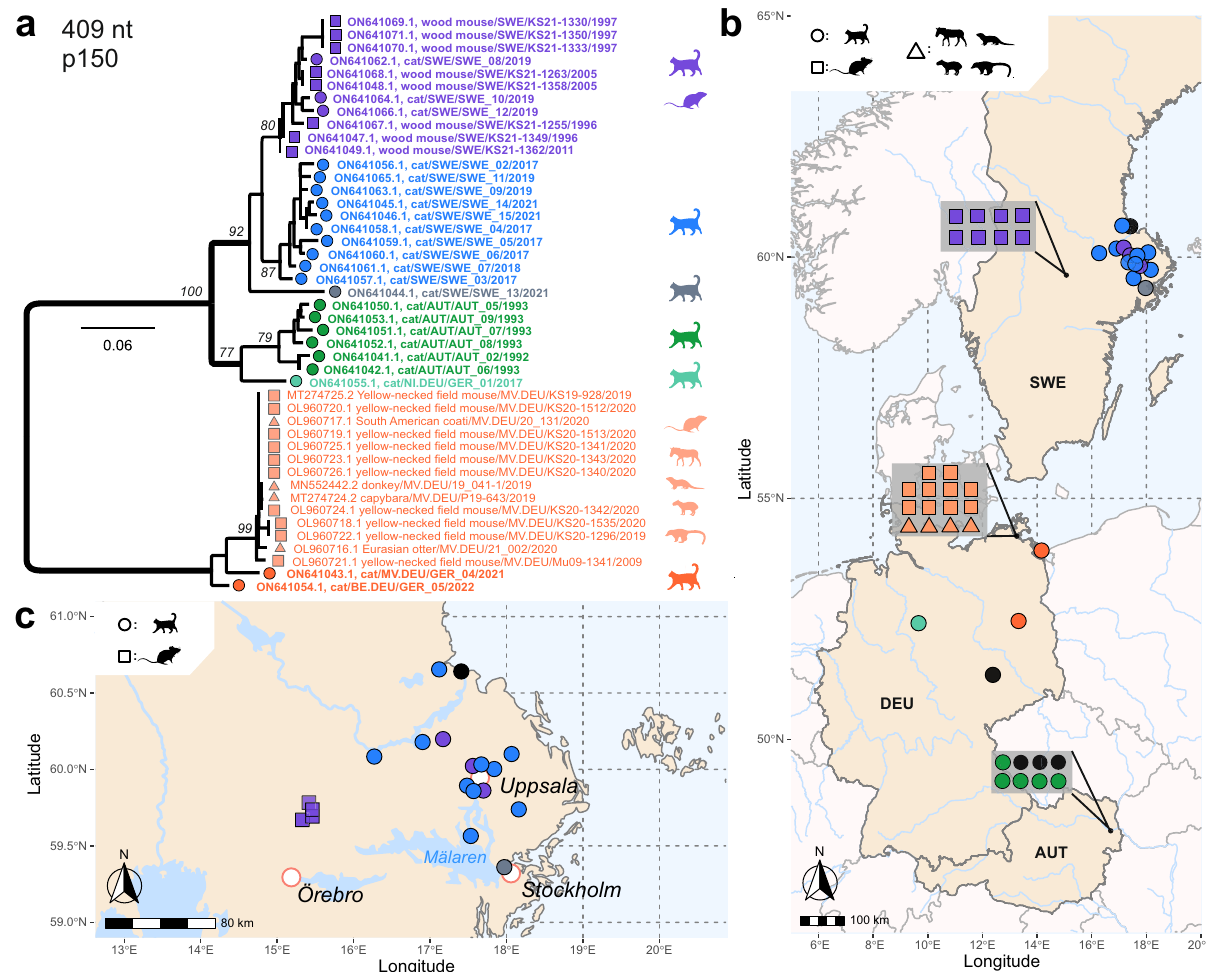
Fig. 6 | Phylogenetic analysis and spatial distribution of rustrela virus (RusV) infections in Europe. a Maximum-likelihood (ML) phylogenetic tree of partial RusV sequences (409 nucleotides, representing genome positions 100 to 508 of donkey-derived RusV reference genome MN552442.2; IQ-TREE version 2.2.0; TN+ F+G4;100,000ultrafastbootstraps).Onlybootstrapvalues ≥ 70atmajorbranches are shown in the phylogenetic tree.RusV sequencenames are shown in the format “ host/ISO 1366 code of location (federal state.country)/animal ID/year ” .